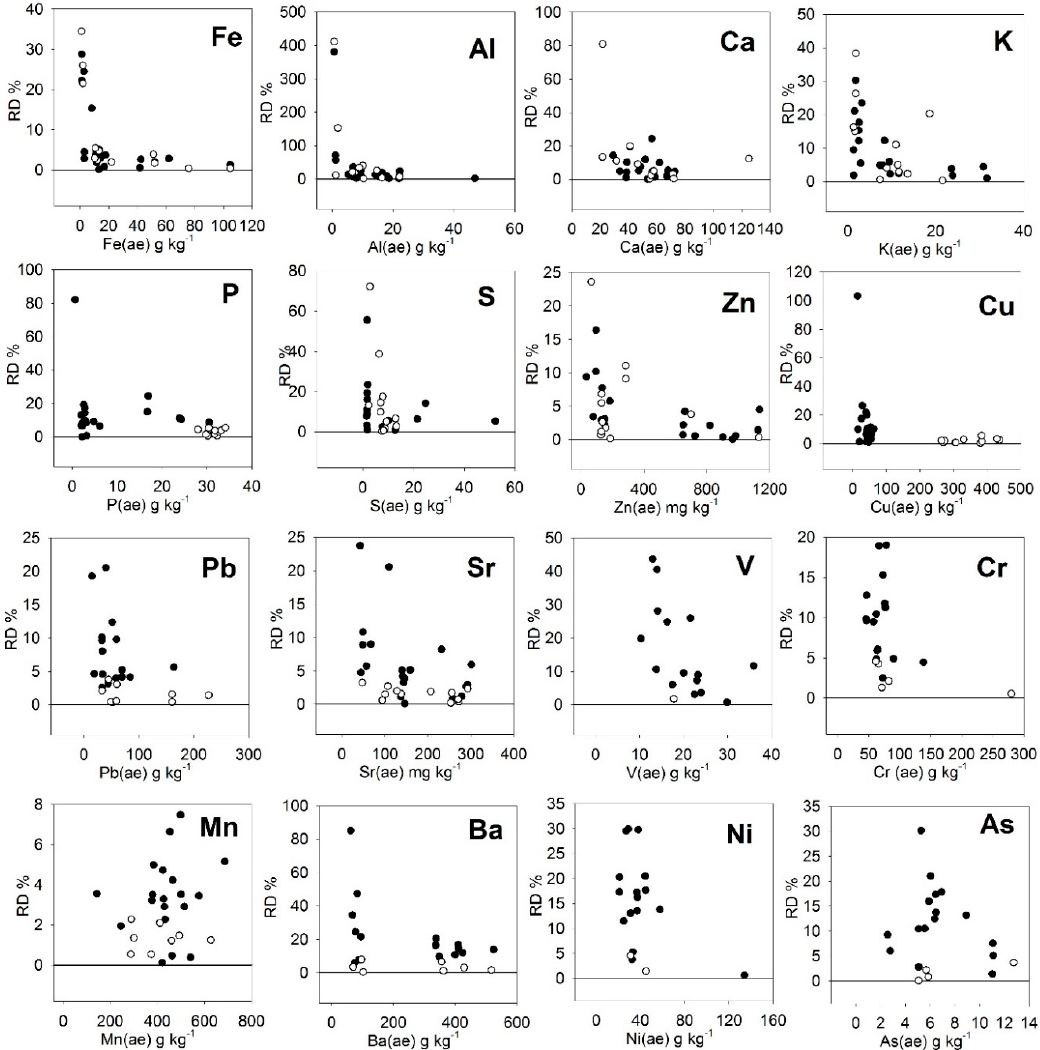
Figure 4. Absolute values of the relative deviations (RD) among predicted and actual aqua regia -extractable contents for major and trace elements.